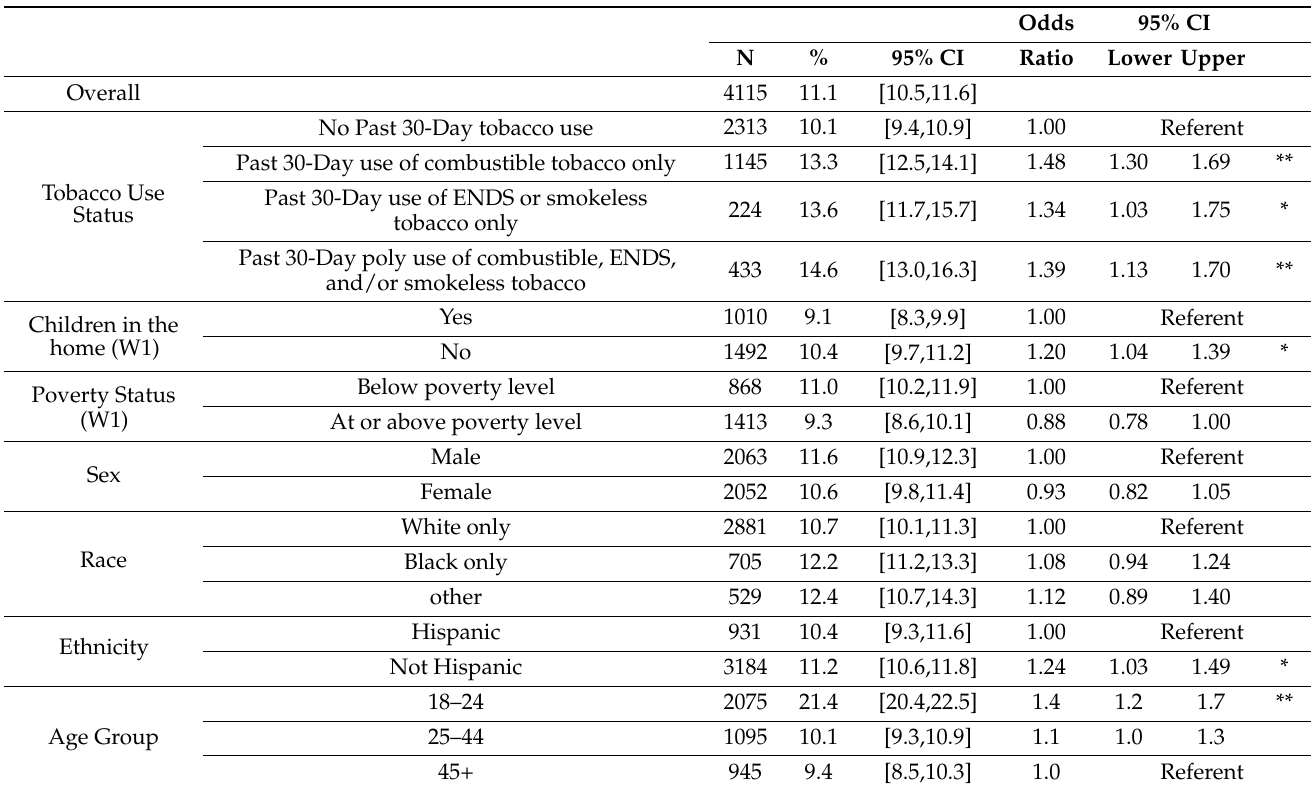
Table 3. Characteristics of adults who adopt home tobacco policies between Wave 3 (2015/16) and Wave 4 (2016/18, n =